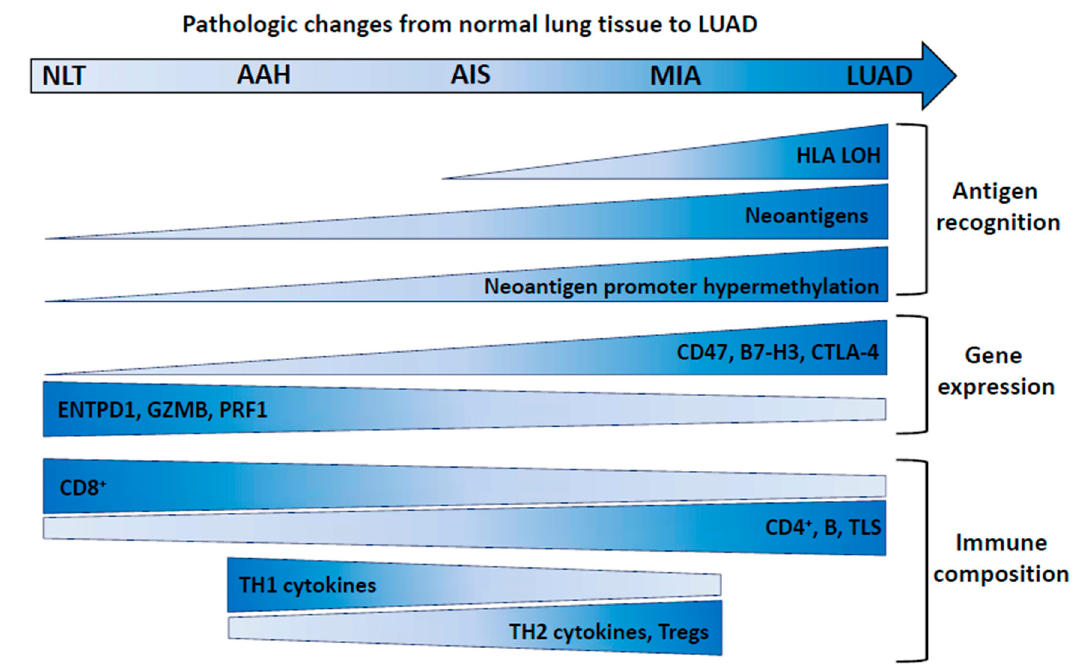
Figure 1. Immune evolution in LUAD pre-invasive lesions. Changes in the indicated parameters along with progression of pre-invasive lesions to LUAD are shown by size and color of the shapes (larger vertical size and darker color: increase). NLT: normal lung tissue; AAH: atypical adenomatous hyperplasia; AIS: adenocarcinoma in situ; MIA: minimally invasive adenocarcinoma; LUAD: lung adenocarcinoma. The indicated evolution of CD8 + cells is according to reference [12], while other studies [10,11] report a different trend. Tregs: regulatory T cells; HLA-LOH: loss of heterozygosity at the HLA loci.